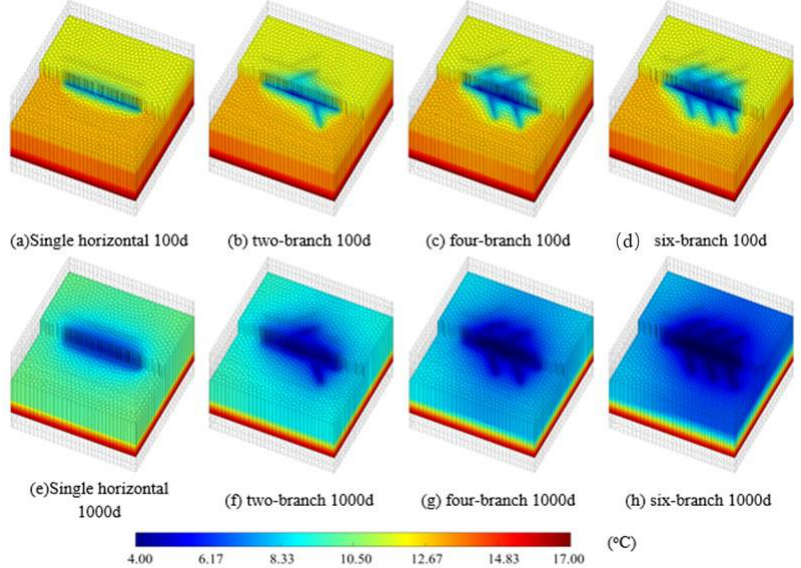
Figure 6. Pressure field in depressurized development of fishbone well with different number of branches.